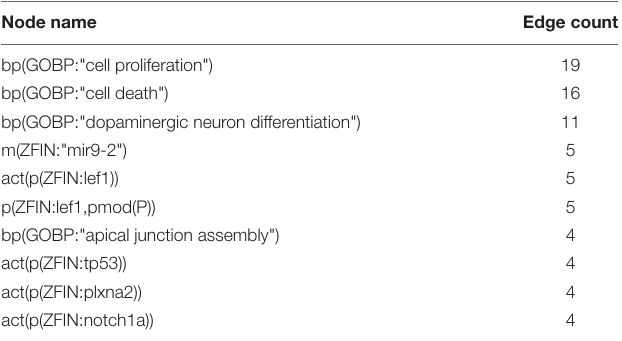
Frontiers in Genetics |